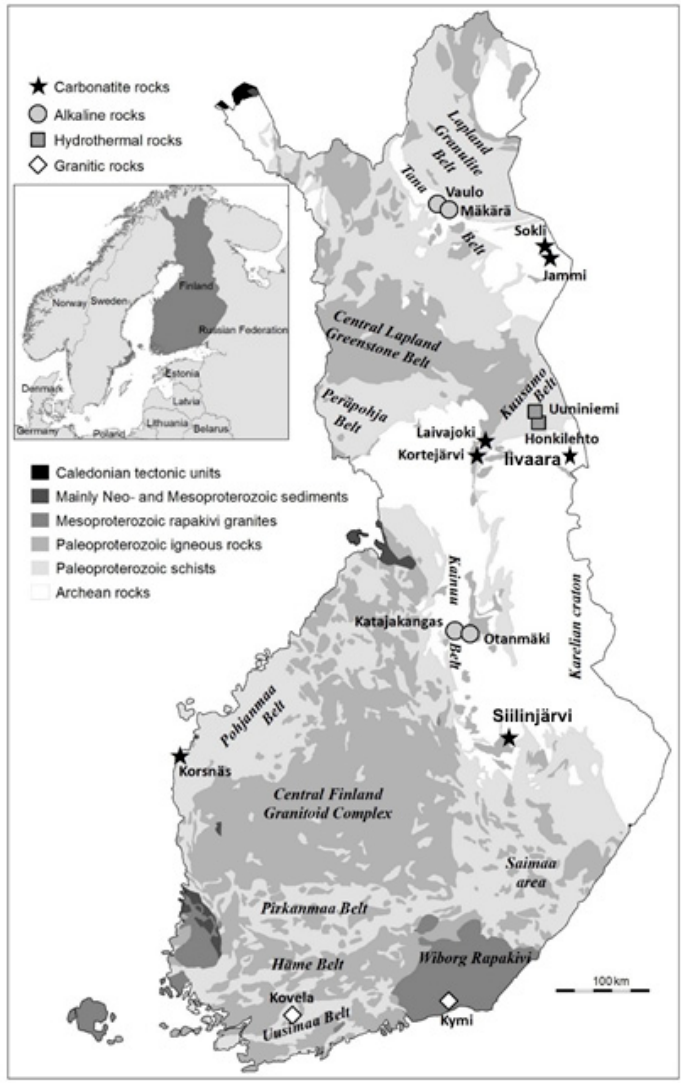
Figure 1. Simplified geological map of Finland with locations of the main REE deposits and occurrences. Modified after Korsman et al. and Nironen et al. [18,19] respectively.